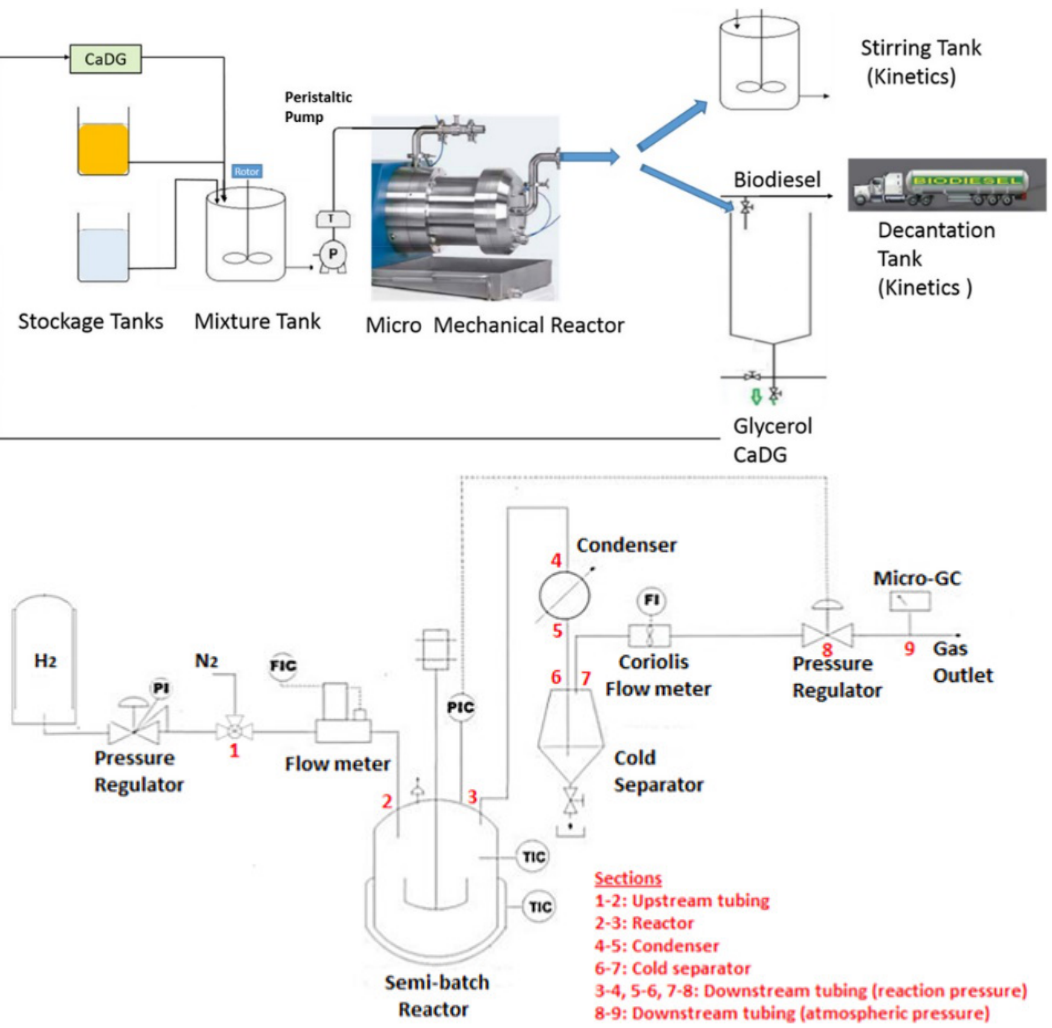
Figure 6. Schematic representations of a semi-continuous flow reactor for biodiesel production. Adapted from [62,63].